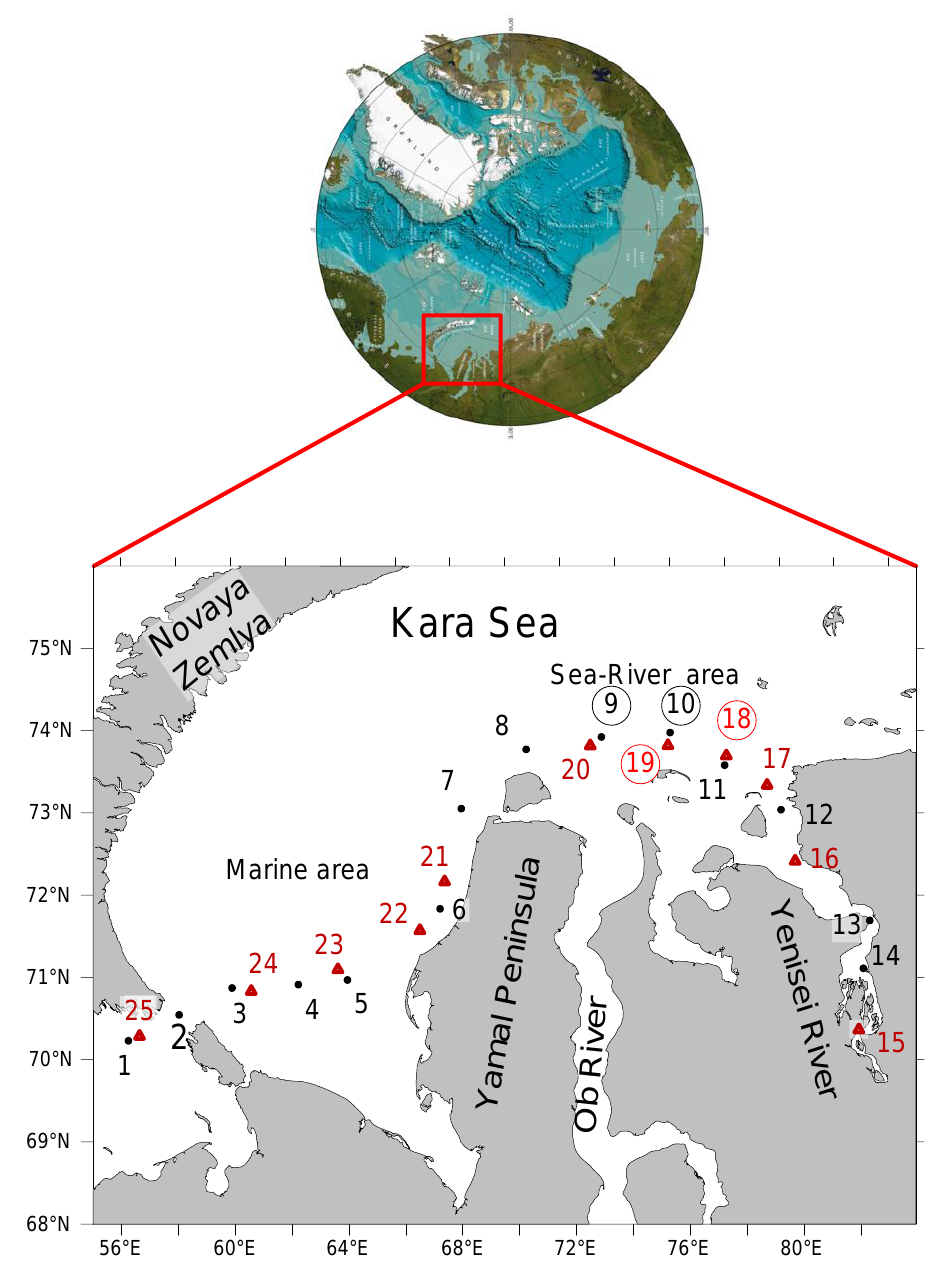
Figure 1. Location of sampling stations in the Kara Sea: circles, stage 1; triangles, stage 2. Station numbers in circles, frontal zone.